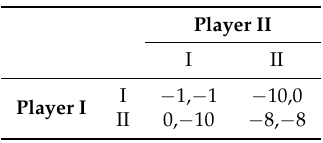
Table 3. Prisoner’s Dilemma.